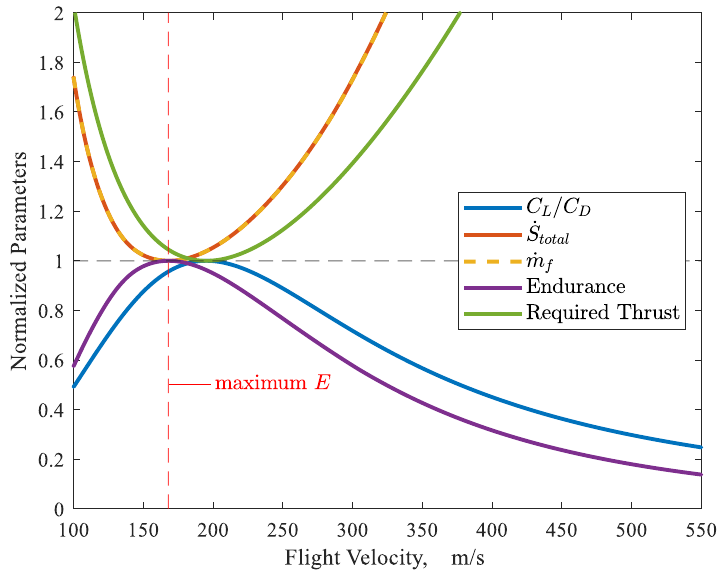
Figure 7. Normalized endurance related parameters over range of flight velocities. F-5E airframe with modelled turbojet engines. Altitude = 9 km.